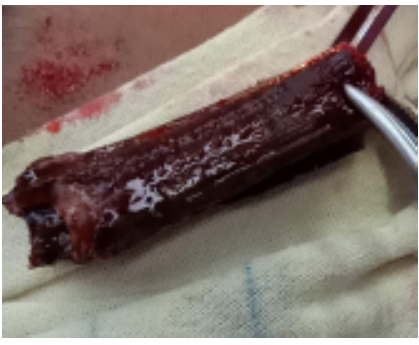
Figure 4: Wooden foreign body measuring 4 cm x 1 cm